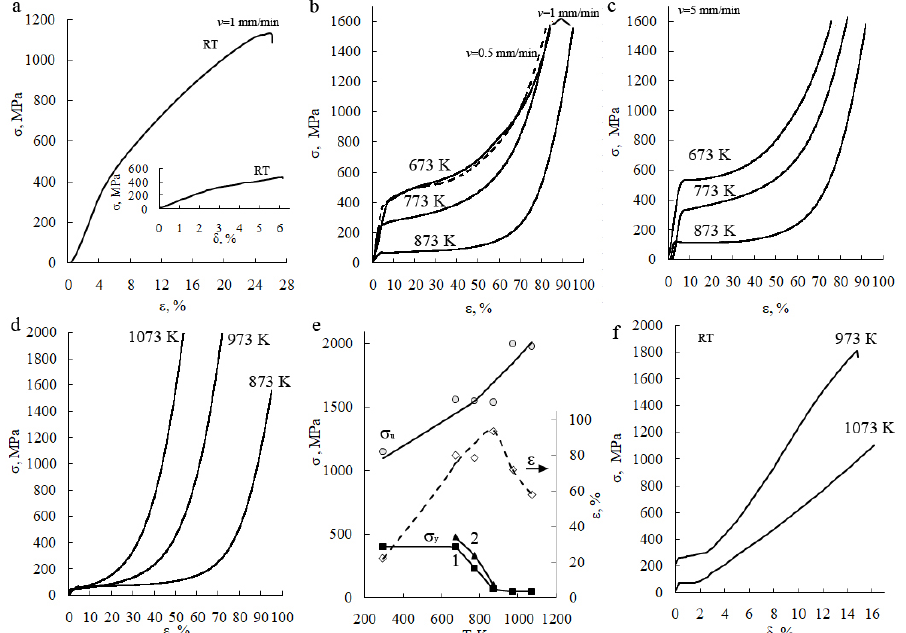
Figure 2. Stress–strain curves for the Cu–14Al–4Ni alloy under compression tests at a rate of ( a , b , d ) 1 (continuous line), ( b ) 0.5 (dashed line), and ( c ) 5 mm/min, at various temperatures (RT, 673, 773, 873, 973, and 1073 K); ( e ) yield stress σ y , ultimate stress σ u , and total compression deformation ε vs. temperature T at rate of (1) 1 and (2) 5 mm/min; (insert in ( a )); and ( f ) “ σ - δ ” curves under subsequent tensile tests at RT after (insert in ( a )) quenching at 1223 K or ( f ) MPC at temperatures of 973 and 1073